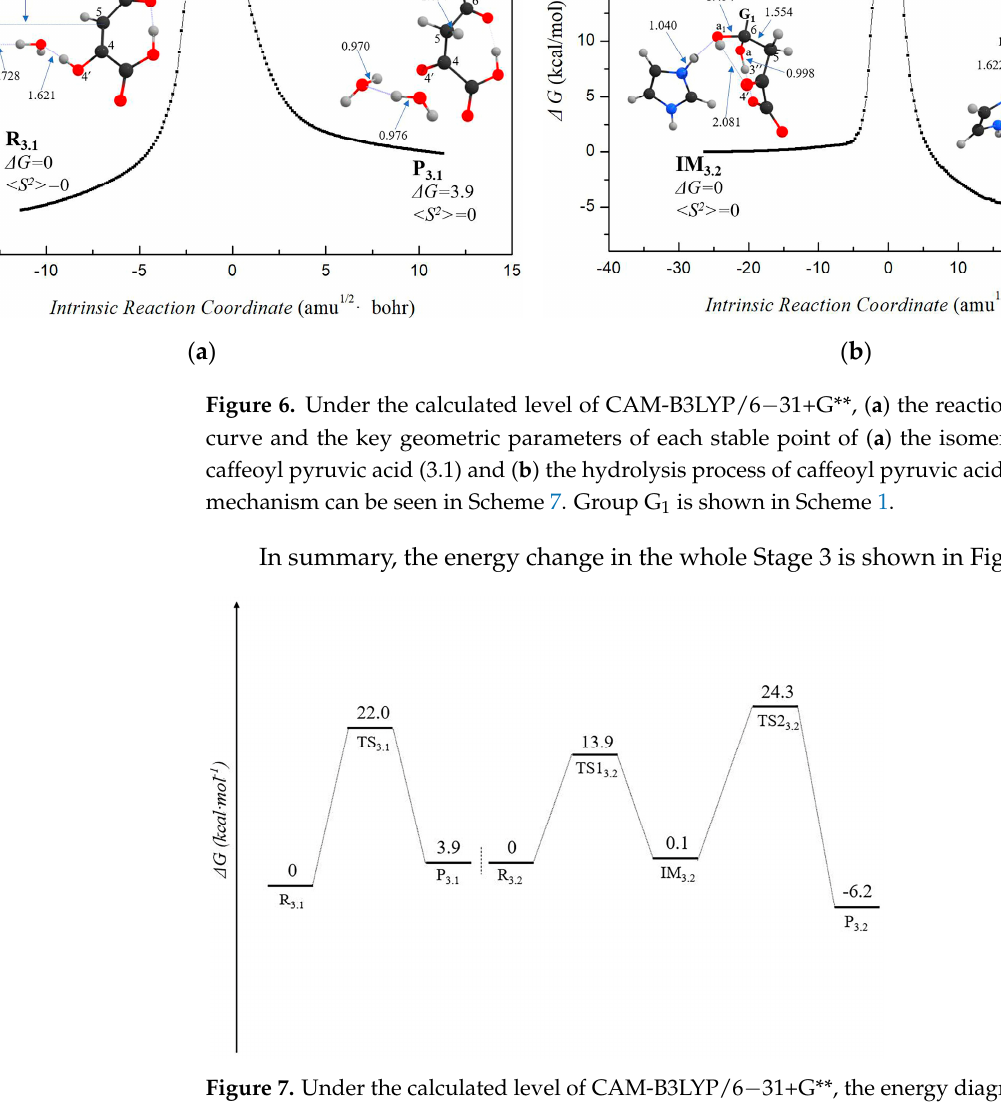
Figure 7. Under the calculated level of CAM-B3LYP/6 − 31+G**, the energy diagram of Stage 3. 4. Conclusions The bioluminescent fungi maintain stable BL by continuously synthesizing luciferin. This cycle of synthesizing luciferin is composed of three stages: biosynthesis of luciferin from caffeic acid, luminescence process from luciferin to oxidized luciferin, and regener- ation of caffeic acid from oxidized luciferin. In this article, we performed mechanistic stud- ies on Stages 1 and 3. In Step 1 of Stage 1, caffeic acid first undergoes phosphorylation and thioesterification to bond with CoA. The generated caffeoyl-CoA transfers caffeoyl to pro- tein cysteine. An acetyl CoA anion is formed after the decarboxylation of malonyl CoA